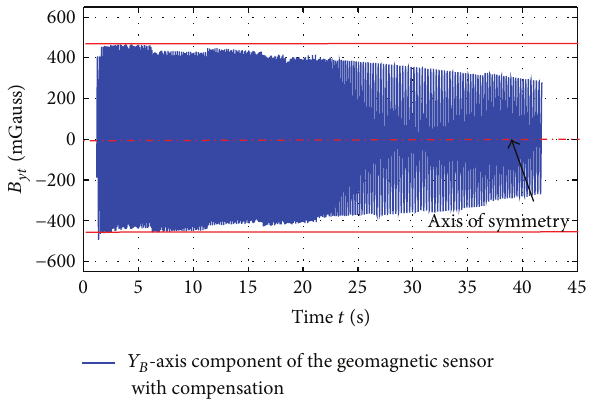
Figure20: 𝑌 𝐵 -axiscomponentofgeomagneticsensorwithcompen- sation.